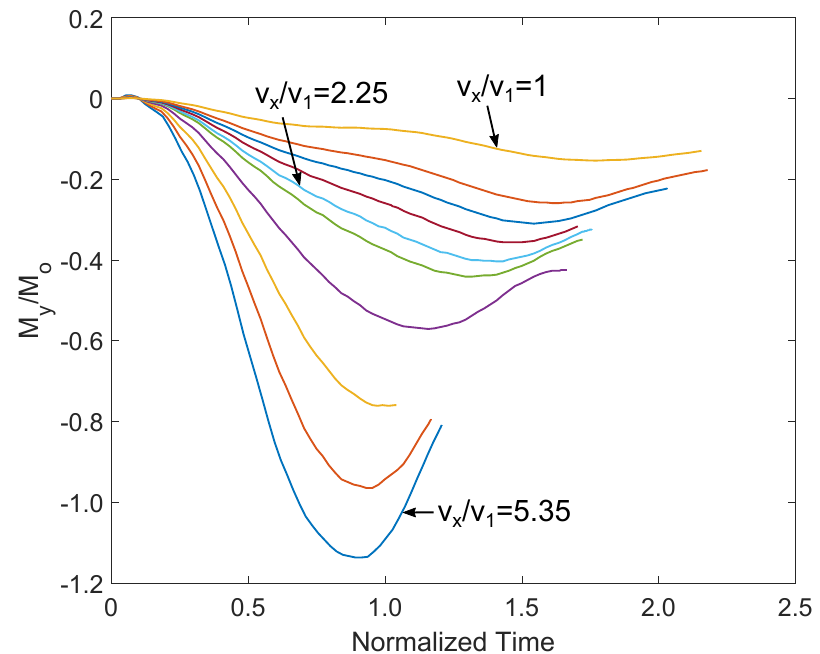
Figure 5. Normalized bending moment at y -direction at the fixed end of the blade, with respect to normalized time, for the different velocities of the killer